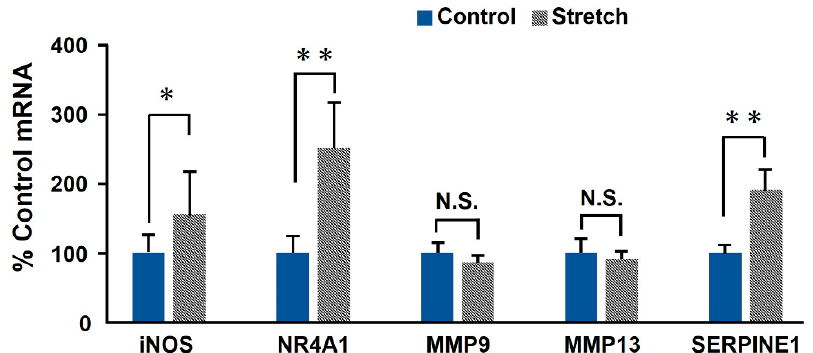
Figure 2. Expression of candidate genes in RASMCs subjected to CMS. RASMCs were subjected to CMS for 4 h, and the expression levels of iNOS, NR4A1, MMM9, MMP13, and SERPINE1 were evaluated by real-time RT-PCR. The quantity of the transcripts is expressed as a percentage of the control, normalized to GAPDH . Data are presented as the means ± SD ( n = 6); * p < 0.05 and ** p < 0.01 versus control; N.S. indicates no statistically significant difference.